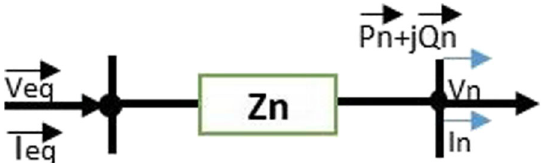
Fig. 6 Equivalent system at local node